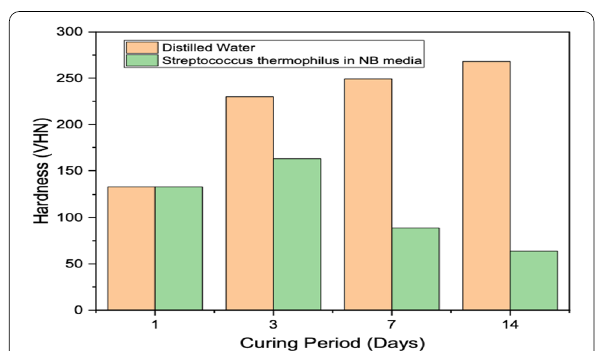
Fig. 3 Micro-hardness data of the hardened pastes cured in distilled water (DW) and Streptococcus thermophilus bacteria in nutrient broth media (NB media)